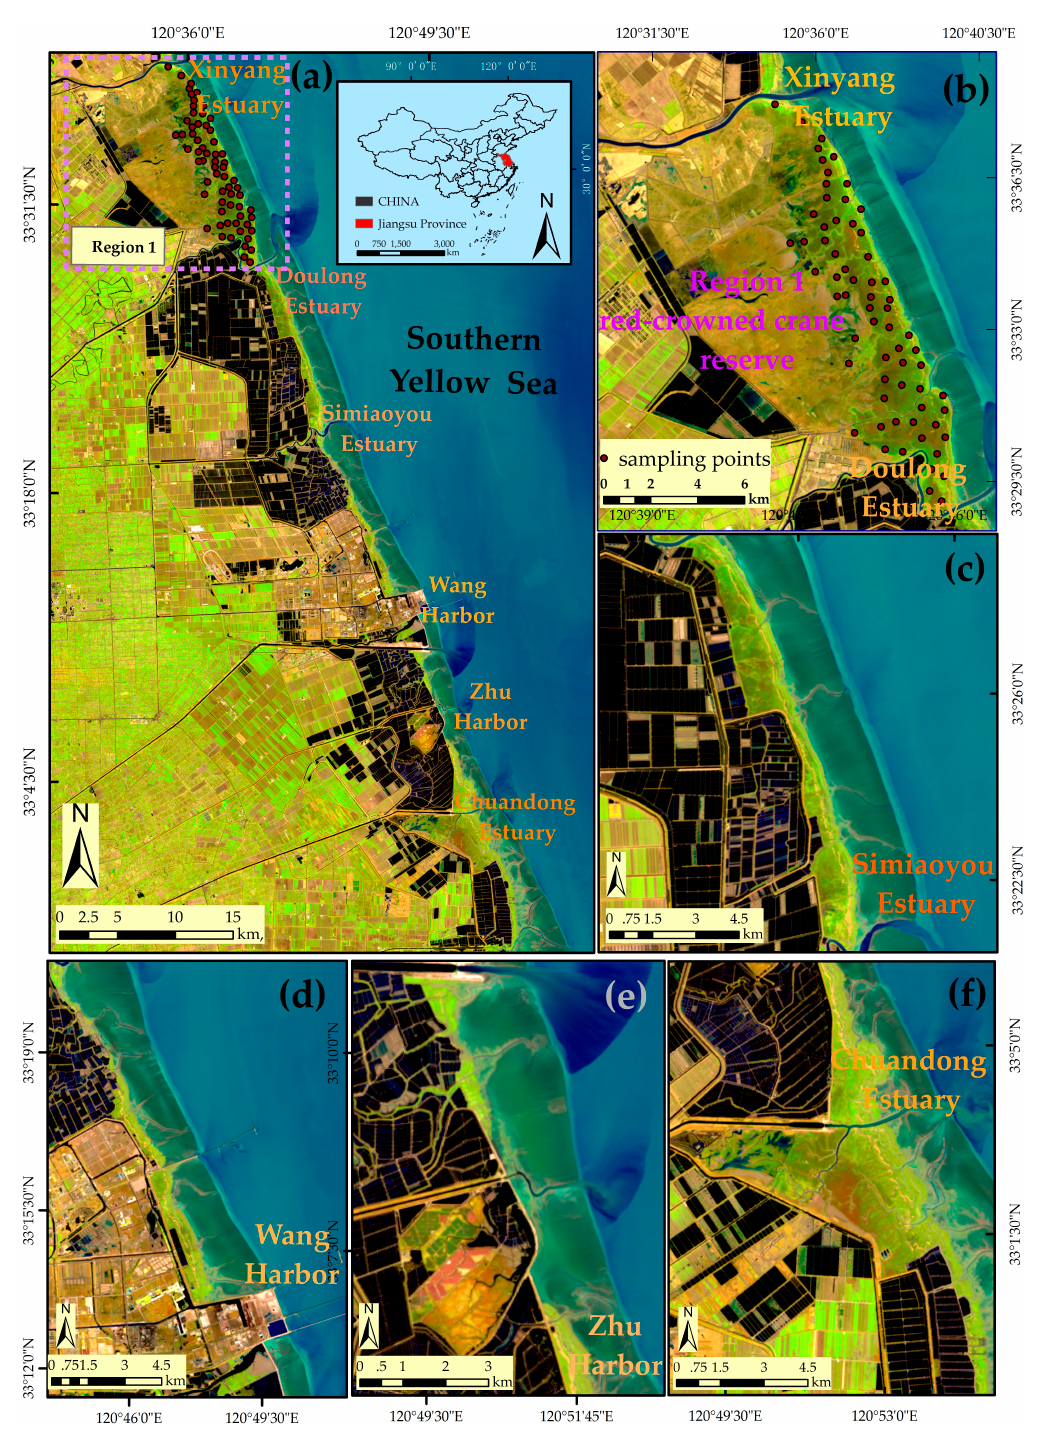
Figure 1. Location of the middle coast of Jiangsu and the spatial distribution of sampling points. ( a ) Overview of the study area in the Landsat OLI RGB composite (R: 6 G: 5. B: 4) image on 29 December 2014; ( b ) the red-crowned crane reserve and the distribution of sampling points; and ( c – f ) detailed information of the area from Doulong estuary to Chuangdong estuary.